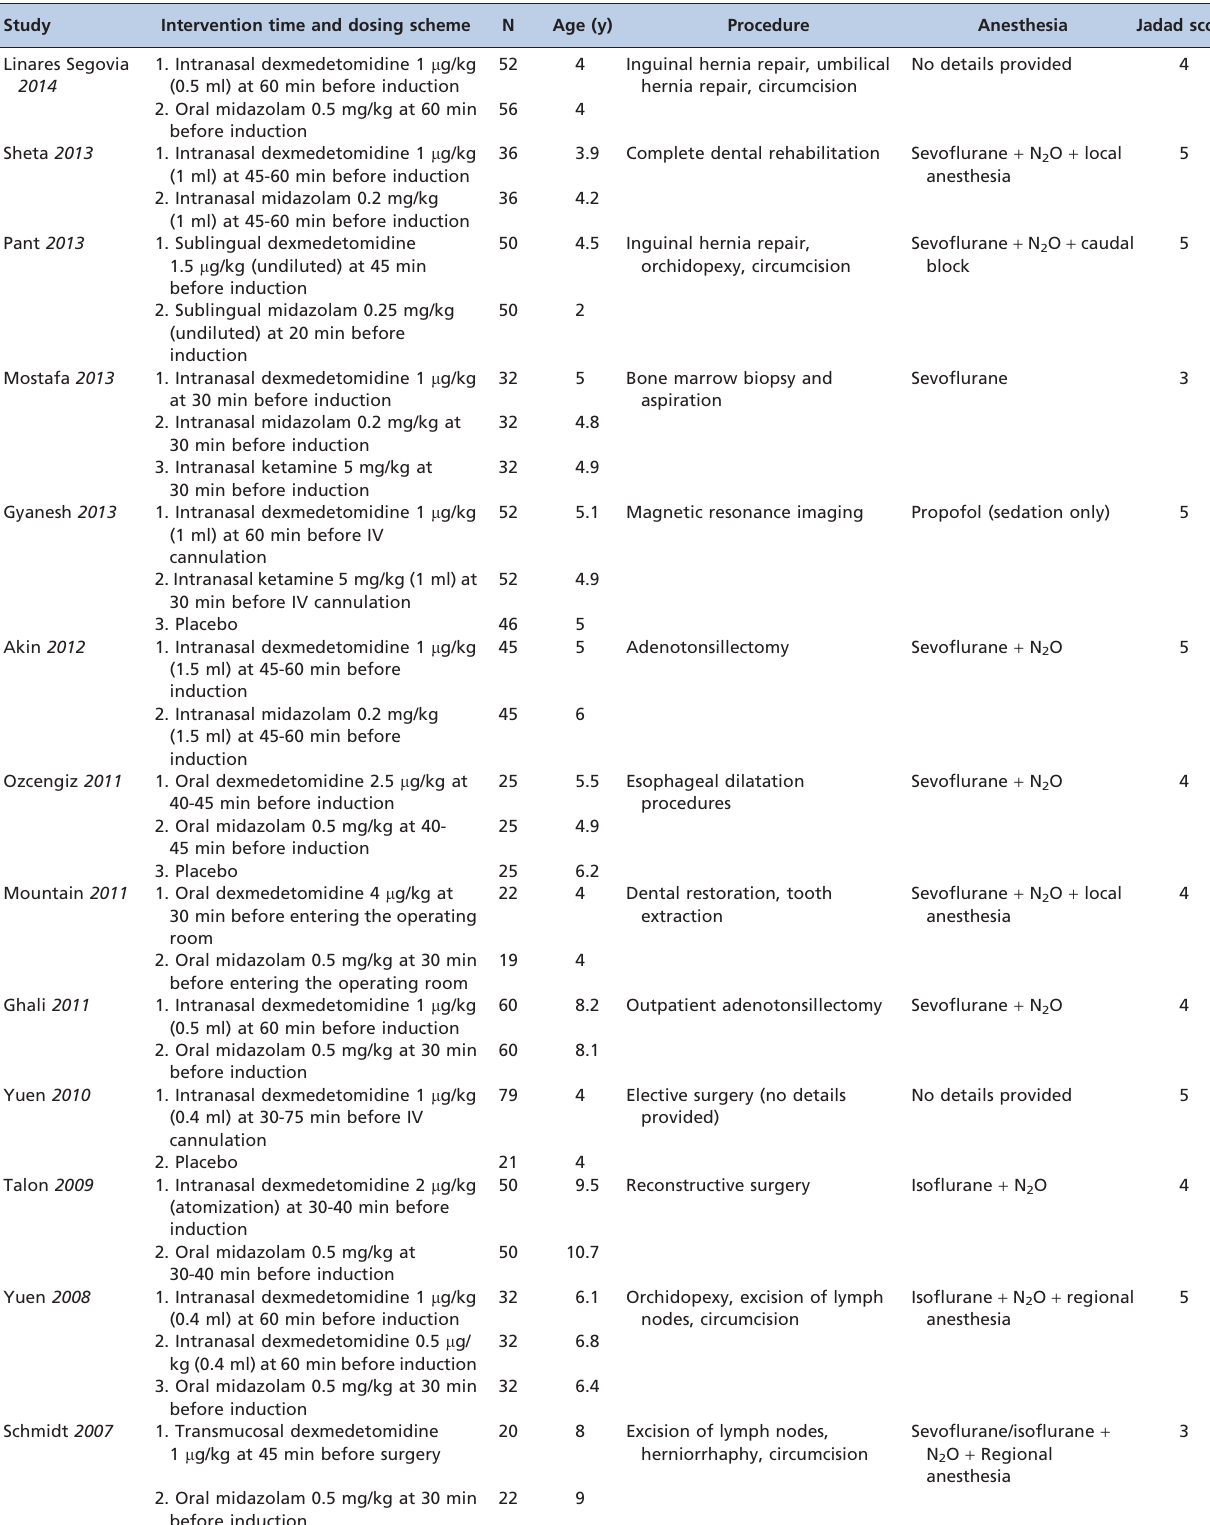
Table 1 - Characteristics of the included studies. Study Intervention time and dosing scheme N Age (y) Procedure Anesthesia Jadad score Linares Segovia